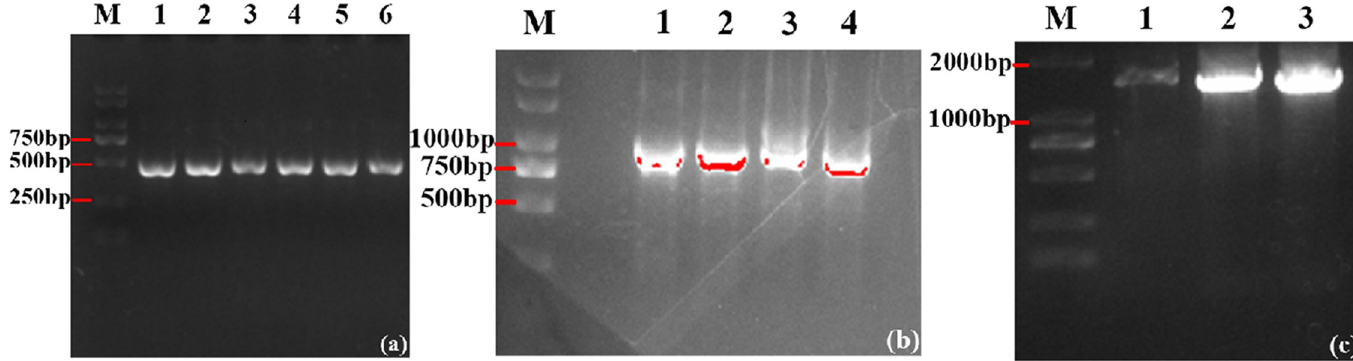
Fig 4. Results of PCR electrophoresis. (a) Result of PCR amplification of left and right homology arms; (b) Result of Km resistance gene PCR amplification gel electrophoresis; (c) Results of homologous fragment gel electrophoresis.